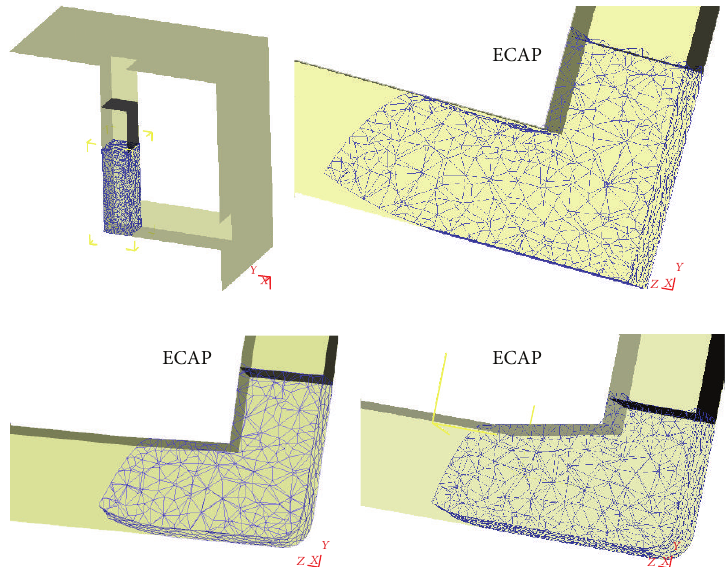
Figure 3: Mesh type used in the workpieces, for all the simulation conditions with DEFOM-3D.